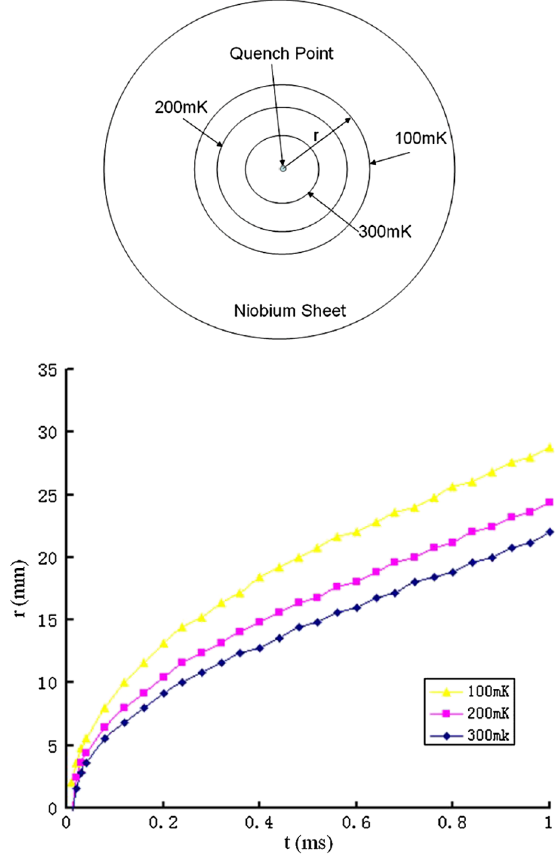
FIG. 11. Temperature rise evolution on the helium side niobium surface of quench area. Top: the sketch temperature distribution while quenching; bottom: the radius’s evolution of certain temperature while quenching.